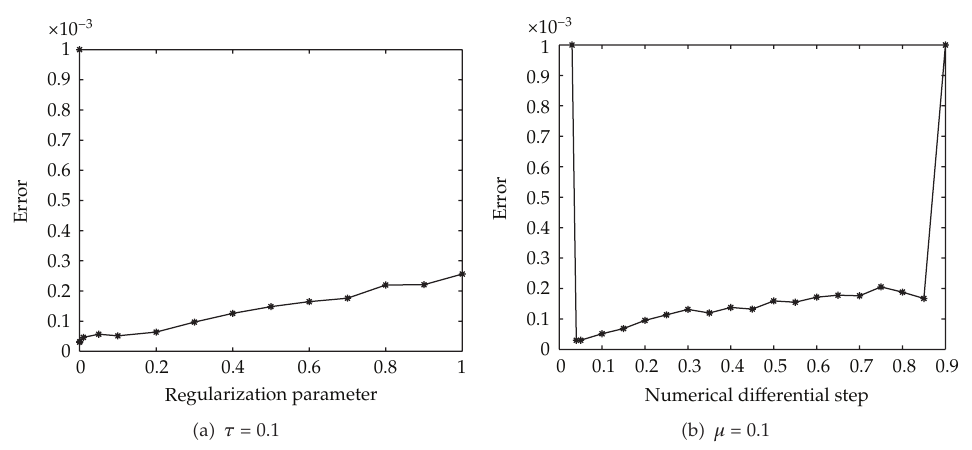
Figure 2: The solutions errors with regularization parameter and di ff erential step.